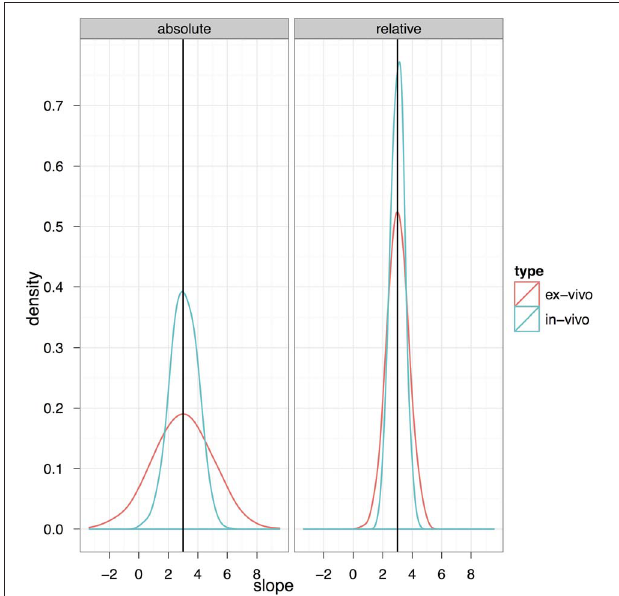
FIGURE 10 | The ability to accurately recapture the slope in an in-vivo experiment with 10 subjects per group and four scans per subject (baseline plus three timepoints with an expected change) and a final expected change of 3% is shown here compared to a cross-sectional experiment with four similar timepoints but using ex-vivo acquisitions.